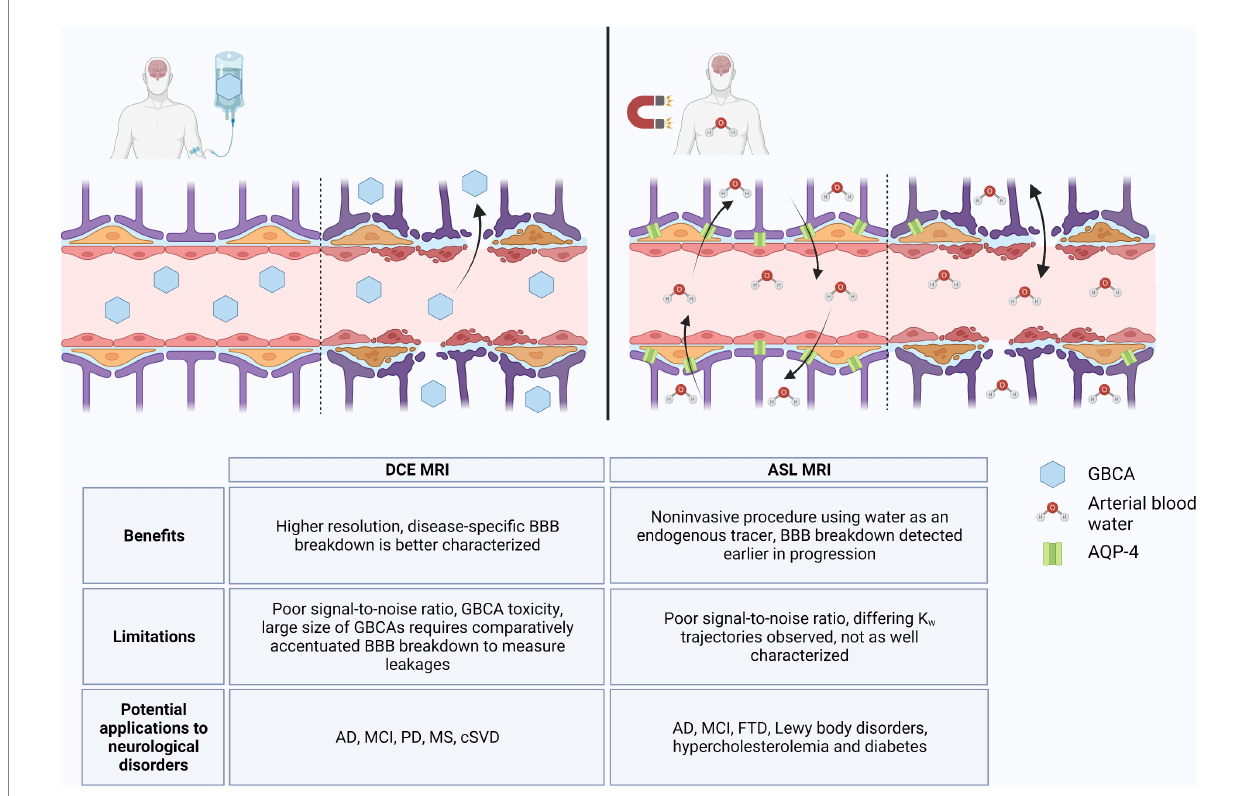
FIGURE 1 DCE MRI vs. ASL MRI. In an intact blood–brain barrier (BBB), GBCAs are restricted from the brain parenchyma, but with loss of TJs, GBCAs extravasate into the brain via paracellular transport, which can be detected by DCE MRI (left) . ASL MRI detects changes in water flux through AQP-4 channels, the abundance of which can change in response to normal aging and neurodegenerative processes. With loss of BBB integrity, water flux can also occur via paracellular transport (right) . Benefits, limitations, and potential applications to diseases for DCE MRI and ASL MRI are listed in table below. Created with